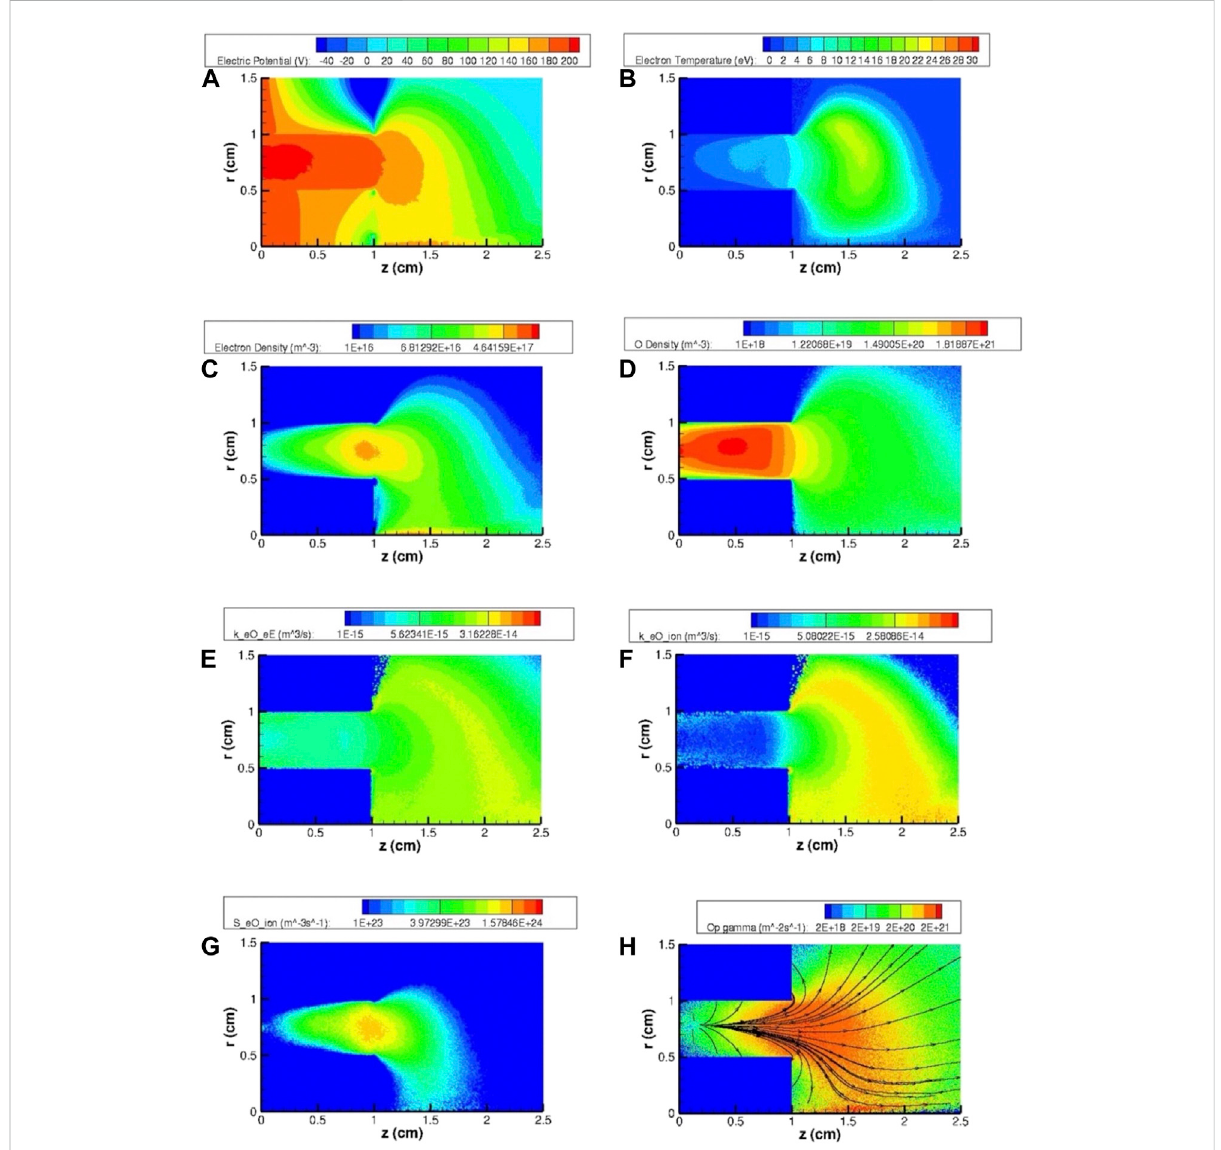
FIGURE 9 Two-dimensionalmaps of themost relevant HT plasma and gas parametersfor theSPT20 nominal case using O 2 (case C)as thepropellant: (A) electricpotential ϕ (V), (B) electrontemperature T e (eV), (C) electrondensity n e (m − 3 ), (D) atomicdensity n O (m − 3 ), (E) and (F)